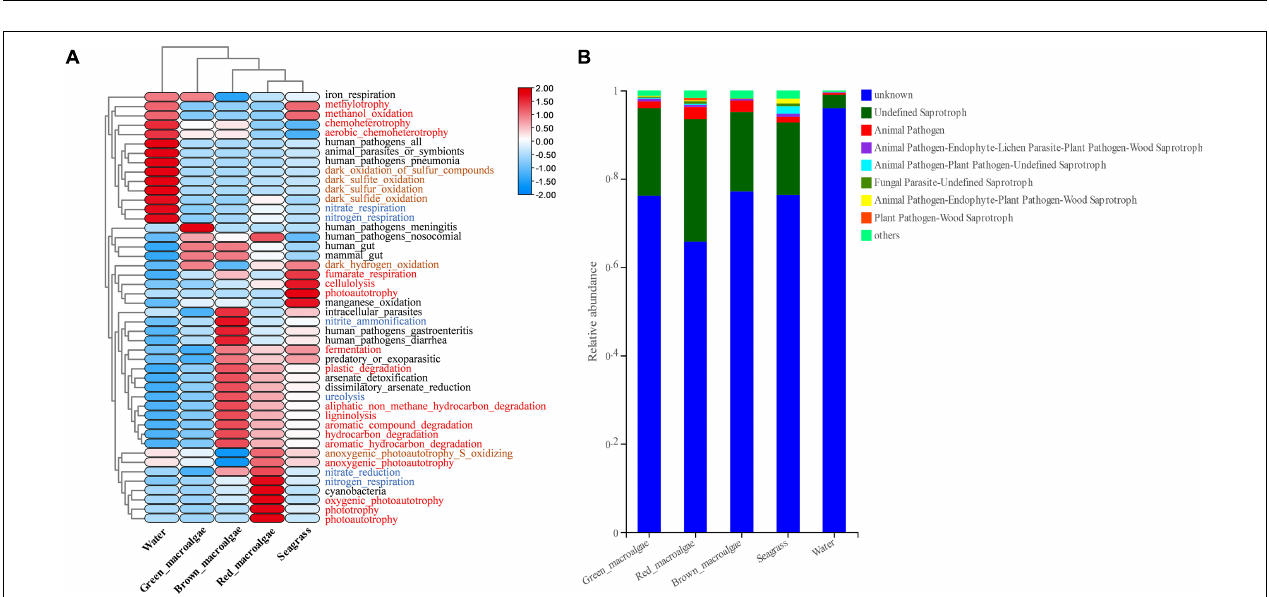
FIGURE 7 | Functional prediction for epiphytic microorganisms. (A) Functional prediction of bacterial composition using FAPROTAX. The red, blue, and brown fonts represent C metabolism, N metabolism, and S metabolism, respectively. (B) Functional prediction of fungal core composition using